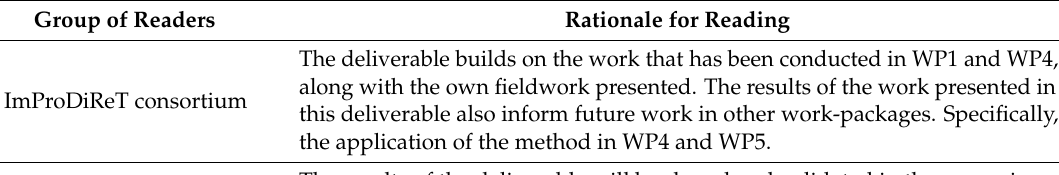
Table A1. Readers of Deliverable 3.1 and Rationale for